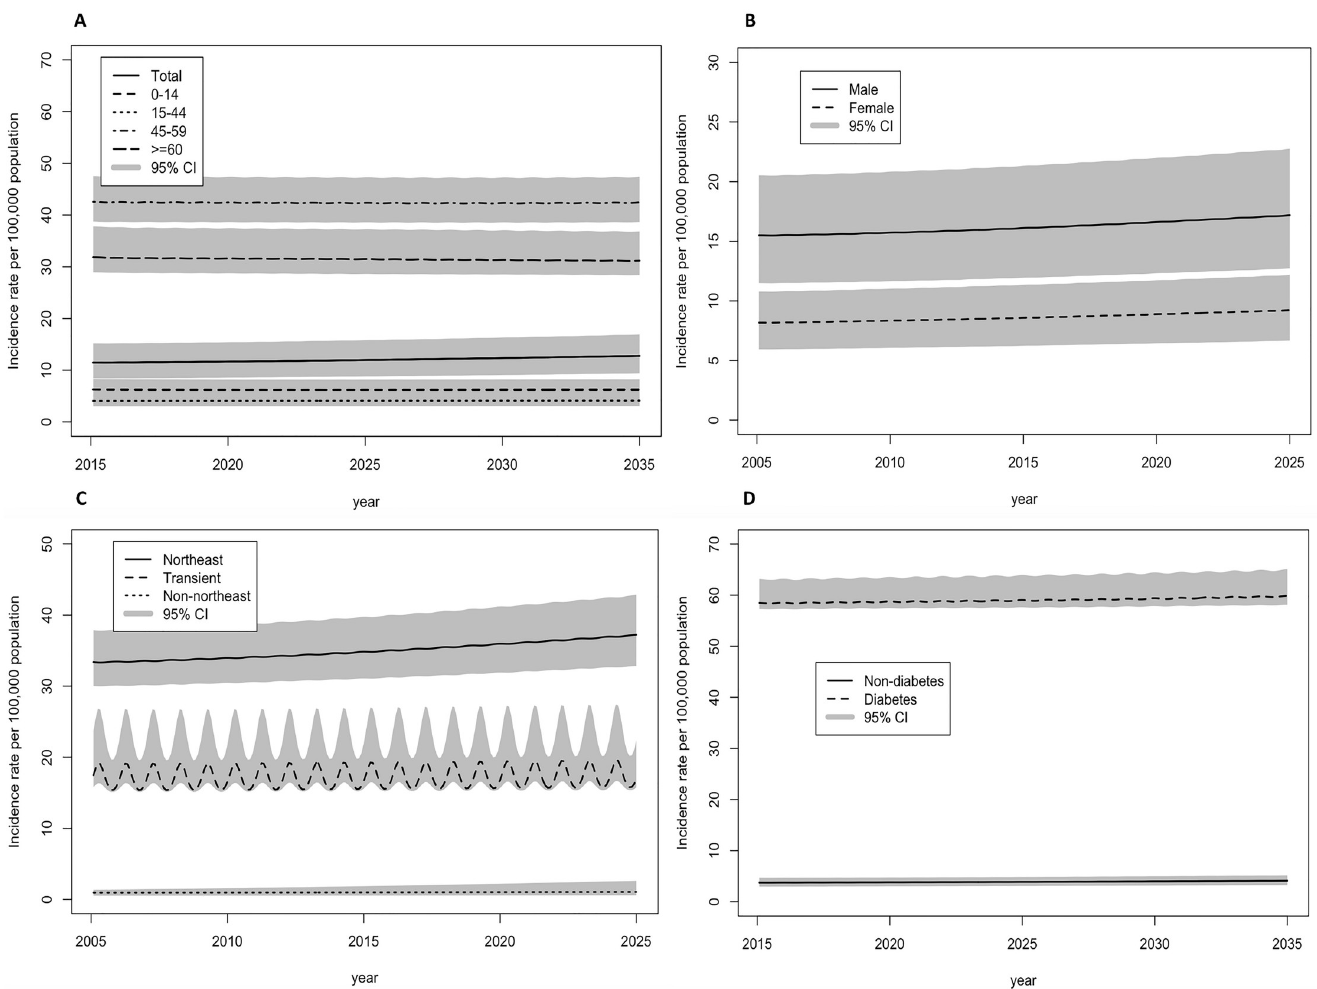
Fig 4. Projections of incidence rate of melioidosis per 100,000 population (95% credible intervals) between 2015 and 2035 in Thailand: (A) By age class (B) By gender (C) By geographical area, and (D) By diabetes